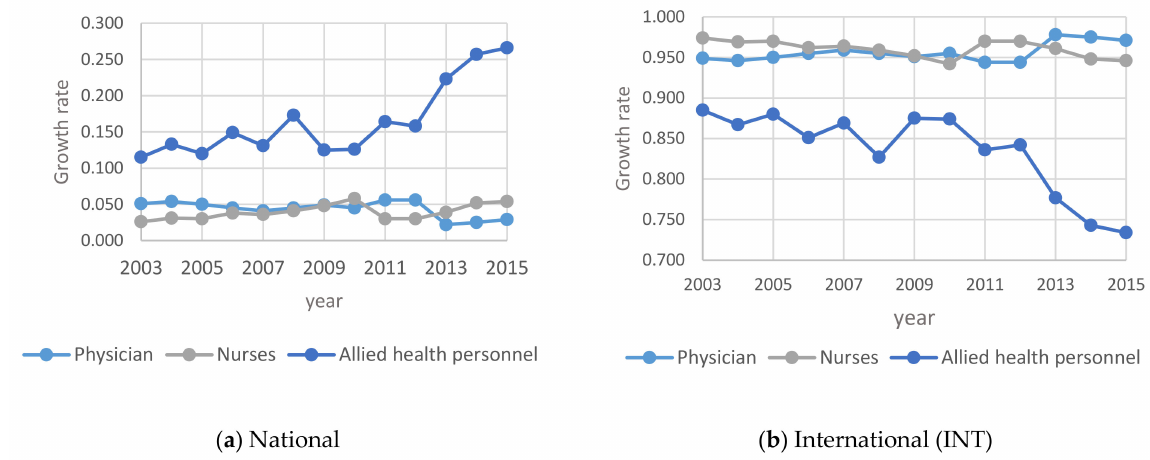
Figure 6. Annual Percentage change for HHR in the PHS between 2003 and 2015: ( a ) National; ( b ) International